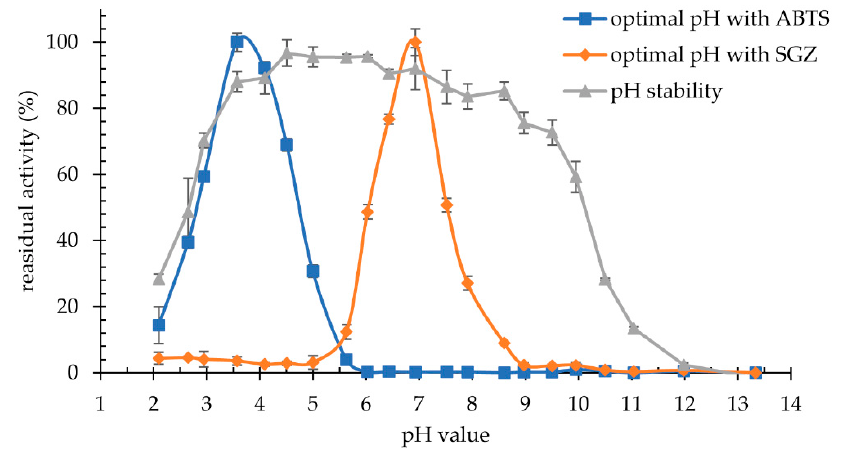
Figure 11. Optimal pH of reaction laccase K. bupleuri G3 with 2,2 ′ -azino-bis(3-ethylbenzothia- zoline-6-sulfonic acid) (ABTS) and syringaldazine (SGZ) and its pH-stability after 24-h incubation at 4 °C.